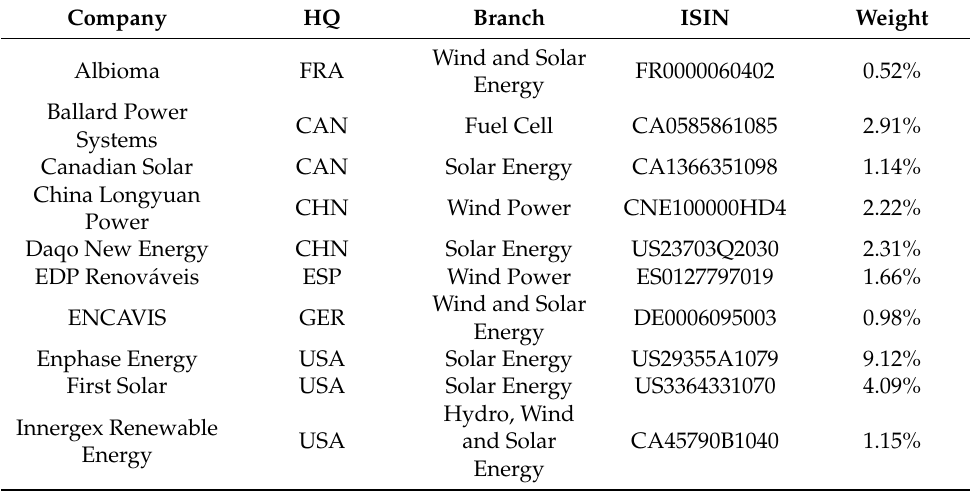
Table A1. Components of RENIXX World